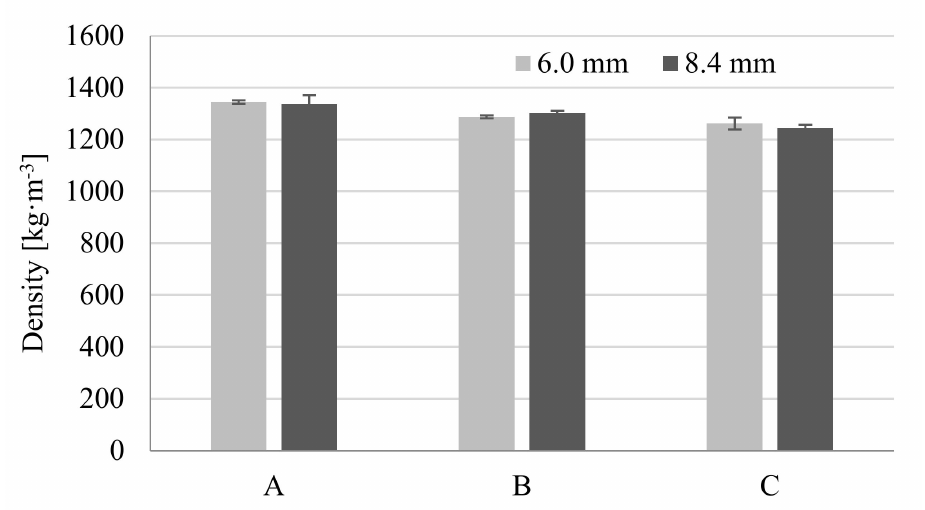
Figure 24. Influence of MuCell ® parameters and moldings thickness on the density of molded parts, where A is a solid sample, while B and C are foamed at 16 and 20 MPa nitrogen pressure respectively. Interestingly, other simulation results, e.g., samples’ density distribution calculated in the simulation correspond very well to the average density of samples obtained in real tests. (Figure 25). Density values of foamed parts marked C ranged from 1.14 to 1.28 g/cm 3 in the transition layer.